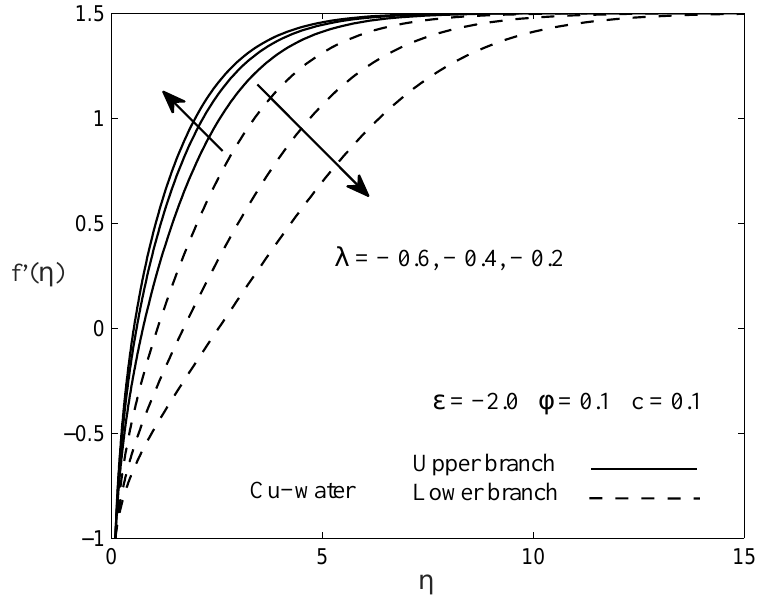
Figure 12. Effect of mixed convection parameter λ on the variation of velocity profiles.